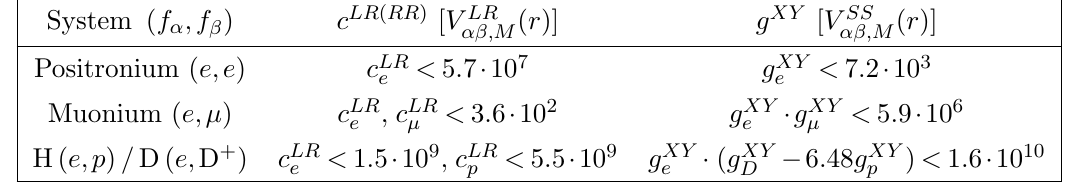
Table 3 . Upper limits on the non-standard coe(cid:14)cients c RL and c RR probed by the right-handed current potential V LR ( r ) and coe(cid:14)cients g XY (for X; Y = L; R ) probed by the scalar-scalar po- (cid:11)(cid:12) tential V SS ( r ). c LR and c RR are constrained from the hyper(cid:12)ne splittings of the systems ( f (cid:11) ; f (cid:12) ), (cid:11)(cid:12) while the g XY are constrained from the 1 S (cid:0) 2 S splittings. To avoid a helicity-suppression we assume three light active Majorana neutrinos with m 1 = 0 : 1 eV and NO masses and mixings. For simpli(cid:12)cation we take c LR ( RR ) (cid:11) ;